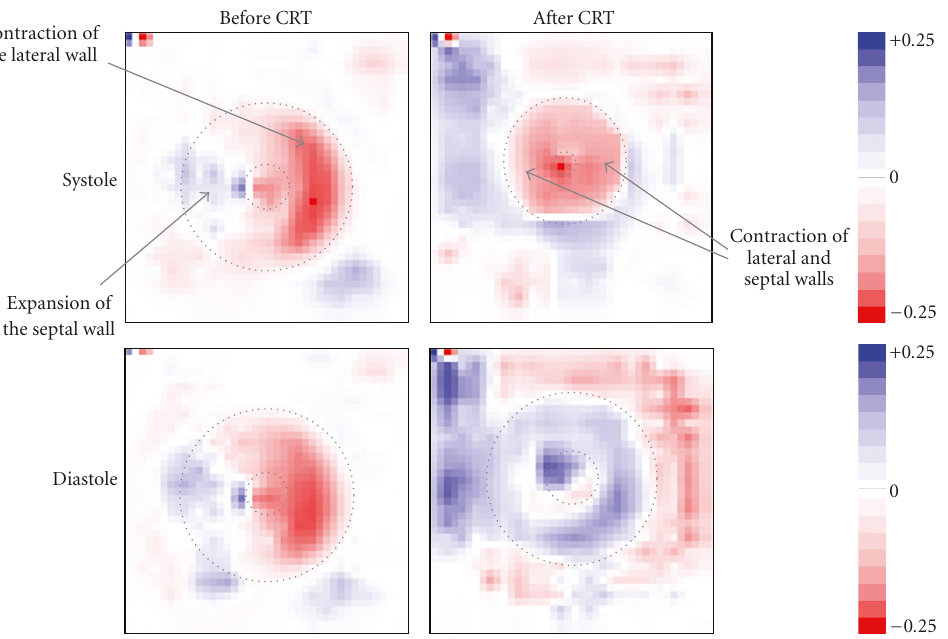
Figure 5: Radial motion of a Group1 patient. A slice from the midcavity is shown in systole and diastole, before and after CRT. In systole before CRT, the arrows indicate the septal and lateral walls. It can be noticed that in the septal wall, pixels present positive values—blue color—while in the lateral wall they present negative values—red color. The expected normal movement would be an overall contraction of the walls, represented by red color. Such movement can be seen in systole after CRT. The arrows in the figure indicate the global contraction movement depicted in tones of reds. The color scale is shown at the top right of the figure.